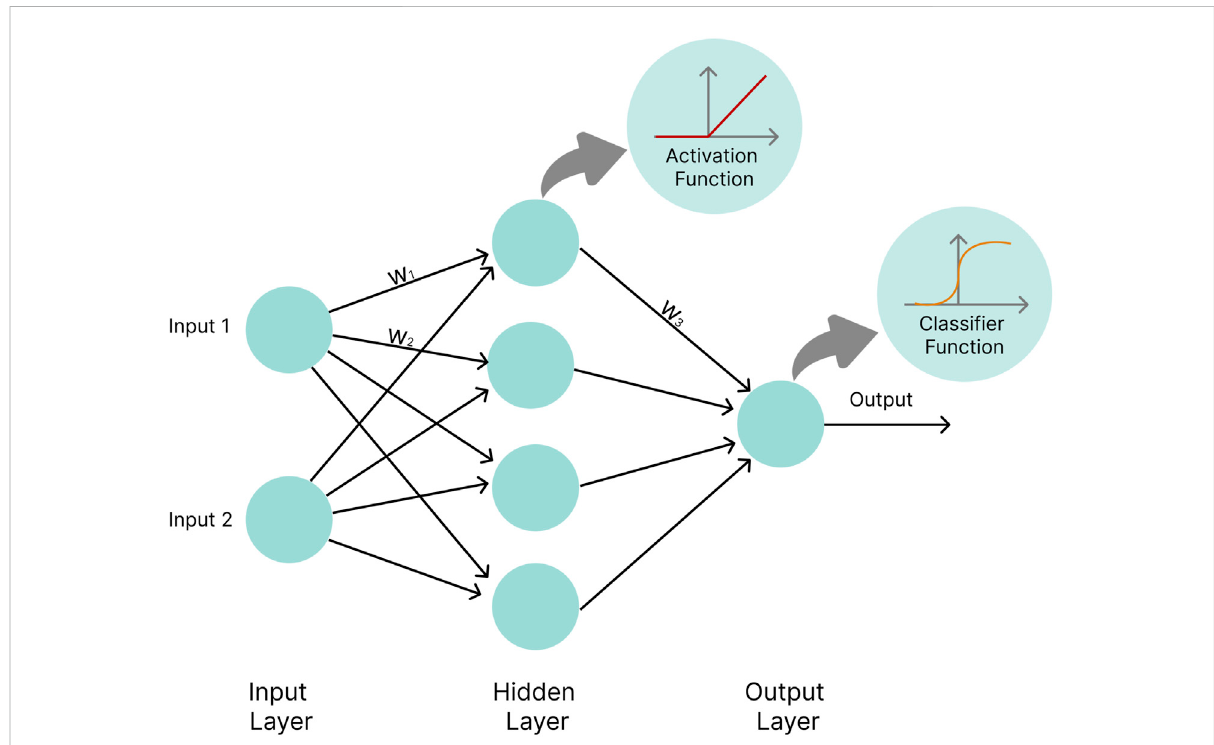
FIGURE 7 Basic neural network architecture. Circles represent neurons. w 1 , w 2, and w 3 represent weights by which values calculated inside neurons are multiplied before being passed on to the next layer. In the hidden layer neurons, values are passed into an activation function (e.g., the ReLU function), while the output layer neuron applies a classi fi er function (e.g., the Softmax function) to input values.